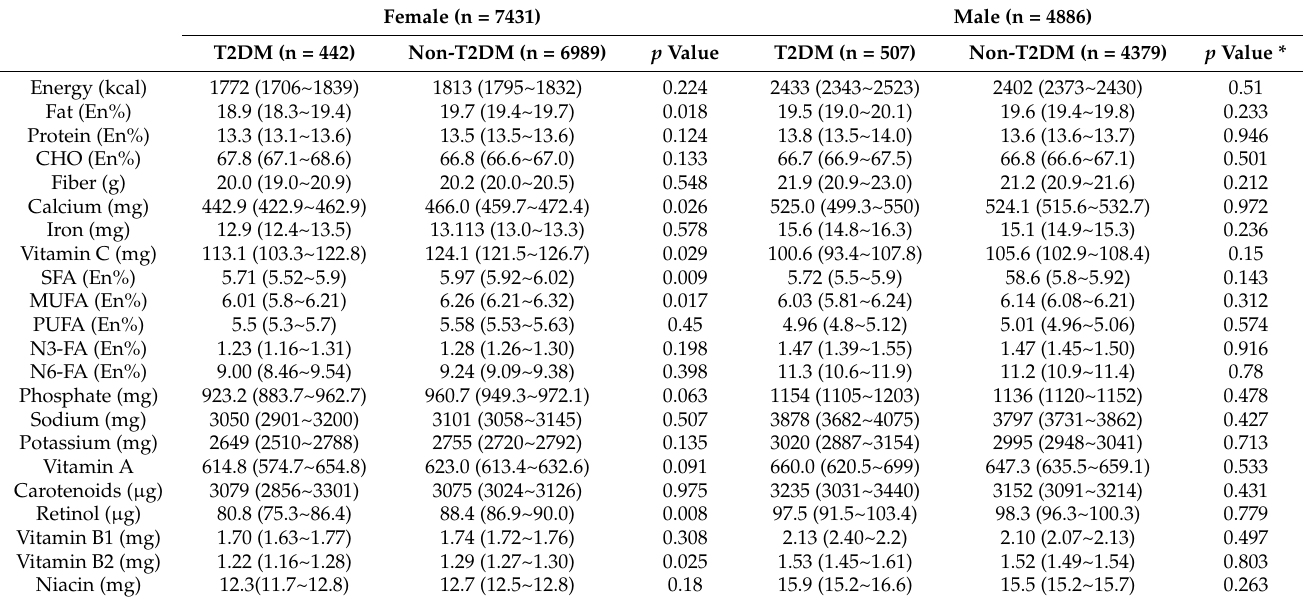
Table 4. Adjusted mean ¶ and 95% confidence intervals of nutrient intake measured by 24 h recall according to genders and diabetic condition after adjustments for covariates.